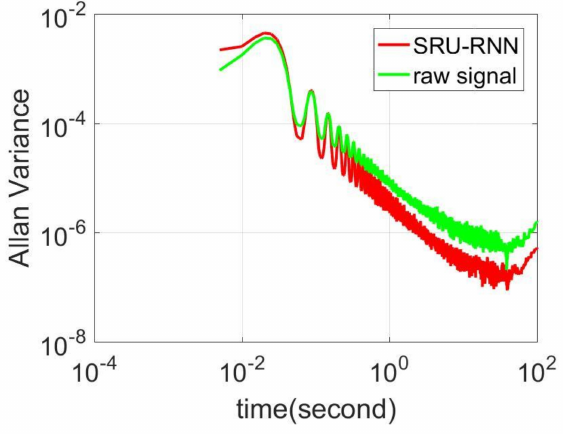
Figure 11. De-noised and raw signals comparison for Z-axis gyroscope.